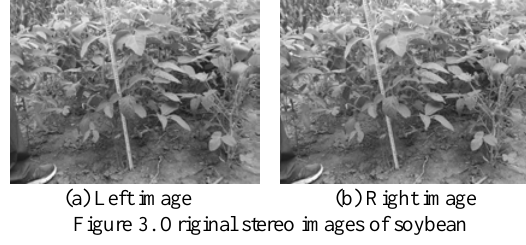
Figure 3. Original stereo images of